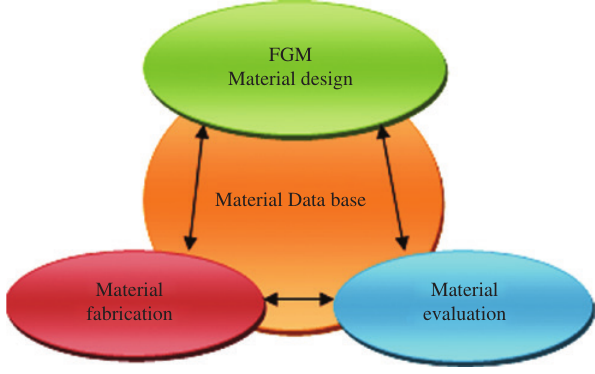
Figure 33: Concept of materialization.